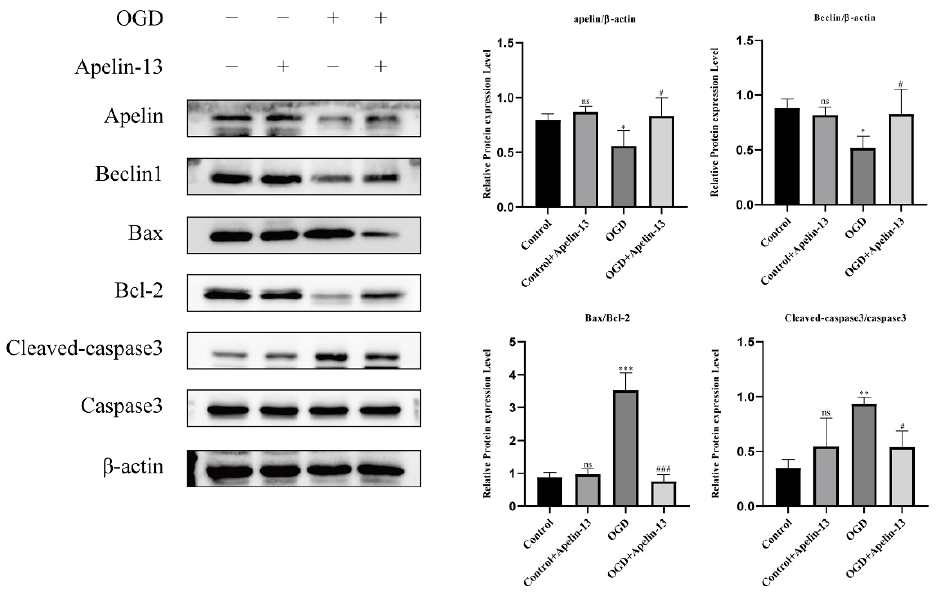
Figure 11. The results of the western blot in Apelin, autophagy, and apoptosis proteins in different groups. For three independent experiments, One-way ANOVA and Tukey’s multiple comparisons test were used to calculate p -values. * Represents that compared with control group and *** p < 0.001, ** p < 0.01, * p < 0.05. # Represents that compared with OGD group and # p < 0.05, ### p < 0.001. ns, not significant. Table 2. Determination of cell viability under different conditions by CCK-8 assay.